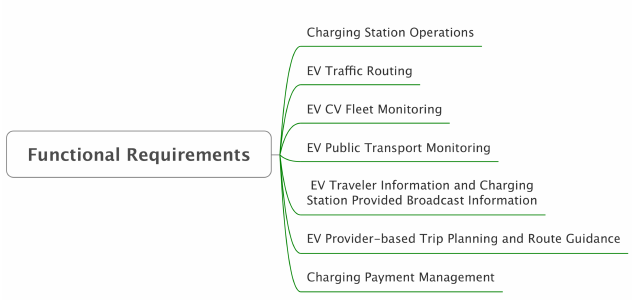
Figure 13. Integration of EVs as a functional requirement in Abu Dhabi’s ITES [2].